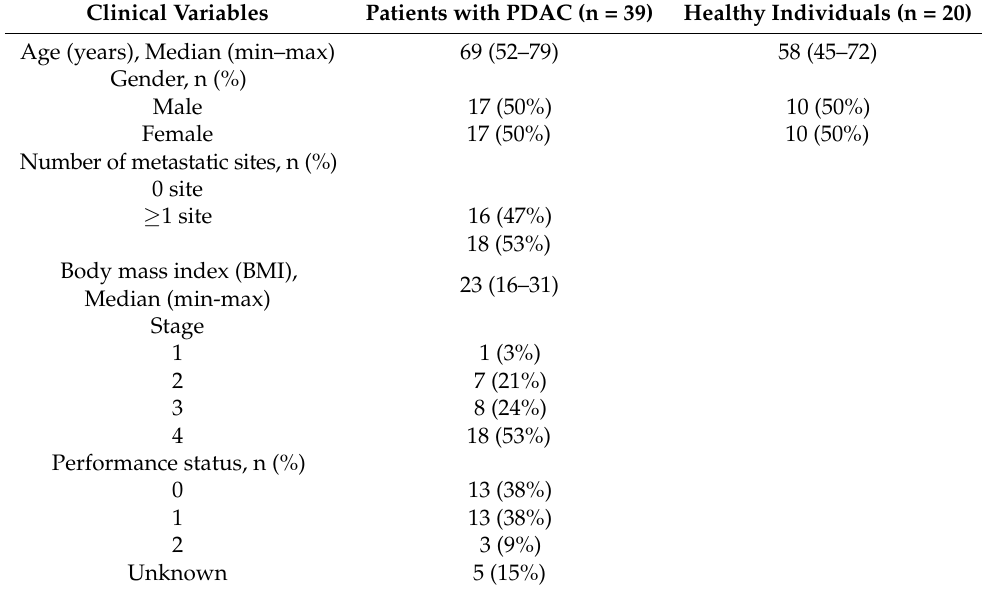
Table 1. Patient demographics and clinical profile for included patients with PDAC, and healthy